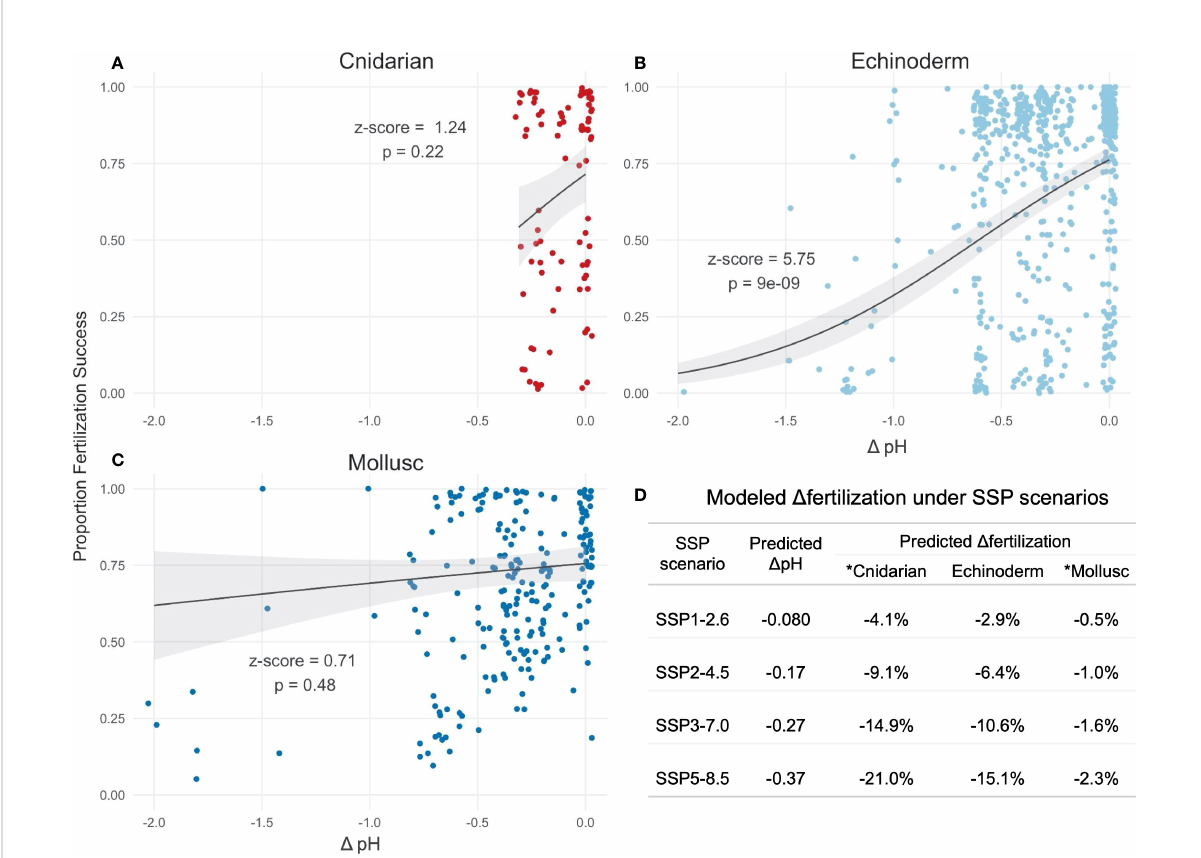
FIGURE 4 Fertilization success by D pH (the difference between experimental pH and control) for (A) cnidarians (6 studies), (B) echinoderms (35 studies), and (C) molluscs (23 studies). Control pH ( D pH = 0) is de fi ned separately by each experimental study, and typically represents present-day ambient pH at experimental location. The meta-analysis was performed using a beta regression model, and indicates that the effect of pH on fertilization rate is phylum-dependent (phylum: D pH interaction, X 2 = 34.3, p = 1.7e -7 ). In all fi gures, each point re fl ects the average percent fertilization reported by one study at each D pH and secondary variable tested, curves indicate the fi tted models, ribbons indicate 95% con fi dence intervals, and z -scores and p -values indicate the signi fi cance of the D pH coef fi cient estimates for each phylum. (D) Models were used to predict the change in fertilization rate under four Shared Socioeconomic Pathways (SSPs) for each phylum, which predict the pH change for the end of the 21st century (IPCC, 2022) relative to 1995 – 2014. *The pH coef fi cient was not a signi fi cant factor in the mollusc or cnidarian models, therefore these predictions should be considered descriptive, particularly for cnidarians for which there is limited data. No fertilization studies were found for crustaceans or